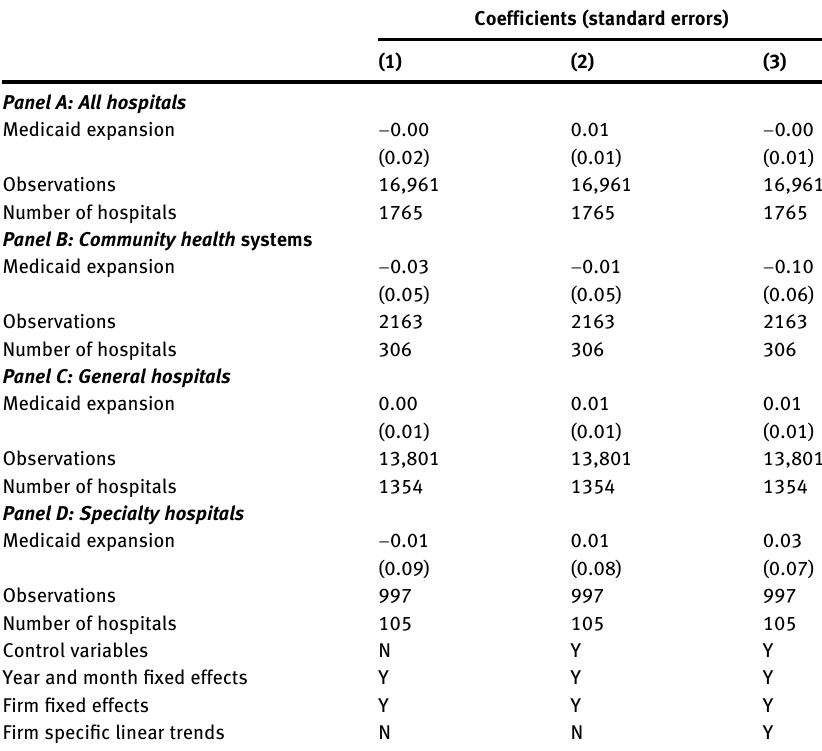
Table  : The impacts of Medicaid expansion on nonpro fi t hospitals excess